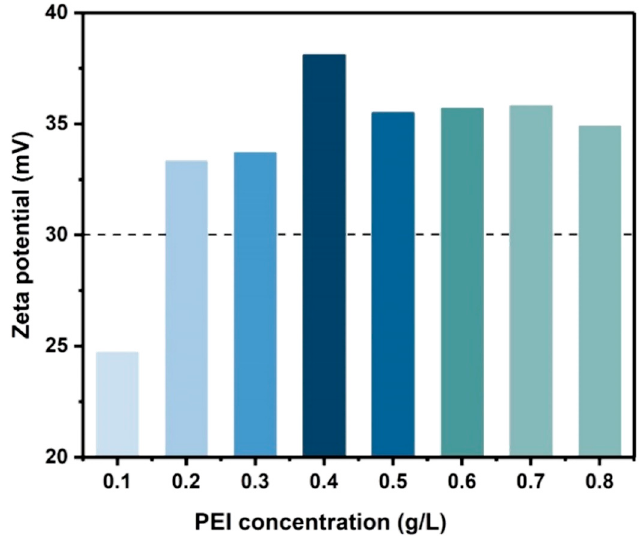
Figure 2. Zeta potential of h-BN particles as a function of PEI concentration for ethanol suspen- sion.